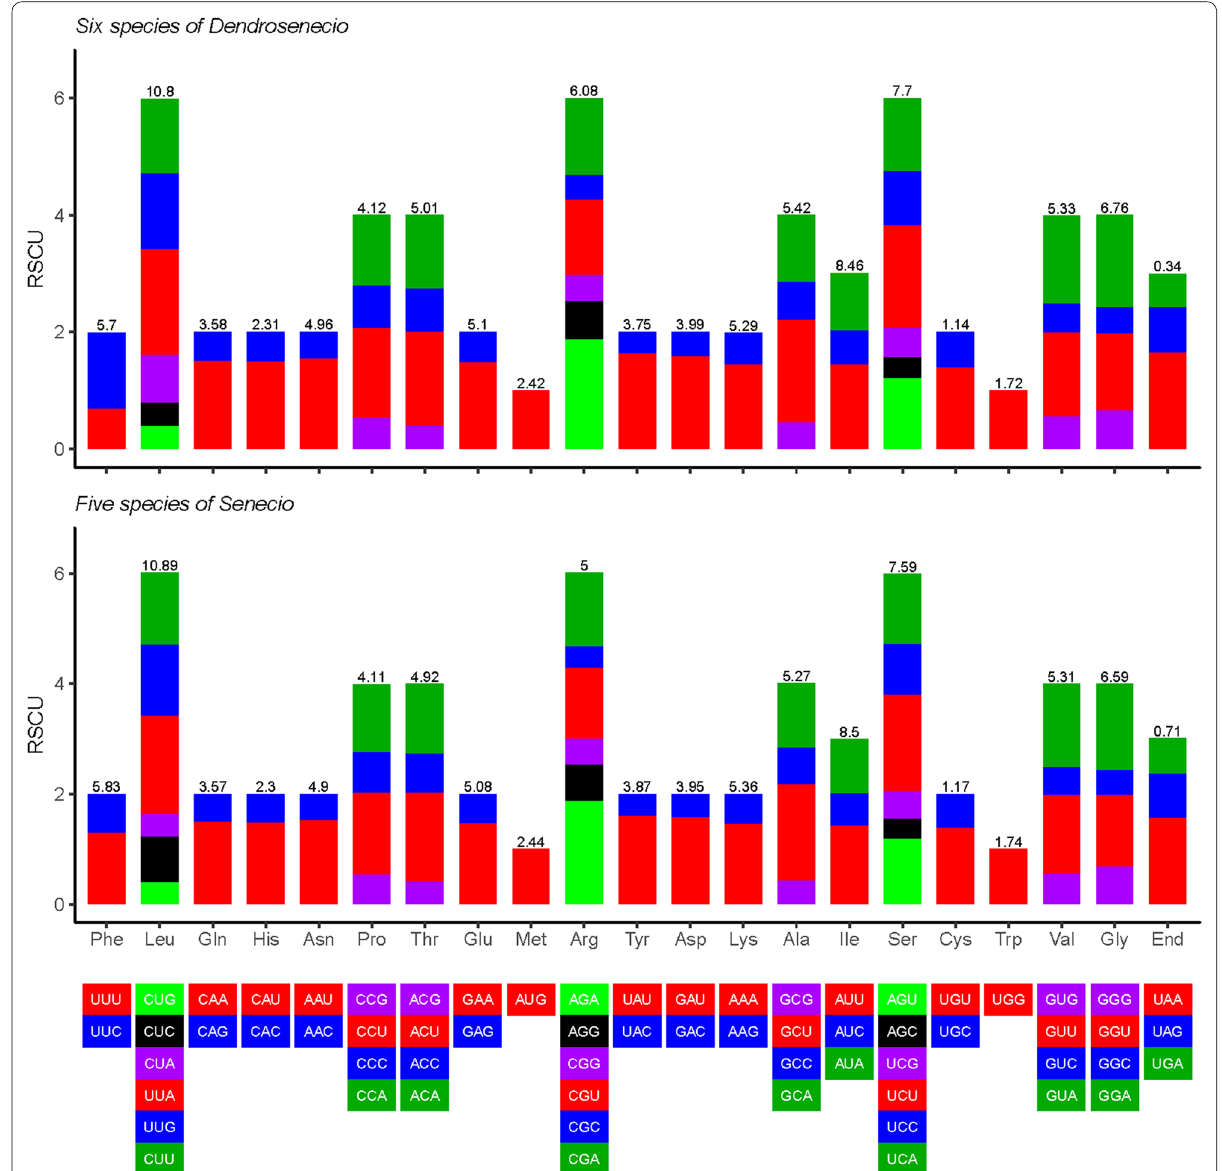
Fig. 2 Details of codon usage biasness in the chloroplast genomes of five species of Senecio and six species of Dendrosenecio. The values at the top of each stack indicate the usage frequency of each amino acid, while the bars (colour coded) depicts the relative synonymous codon usage values for each